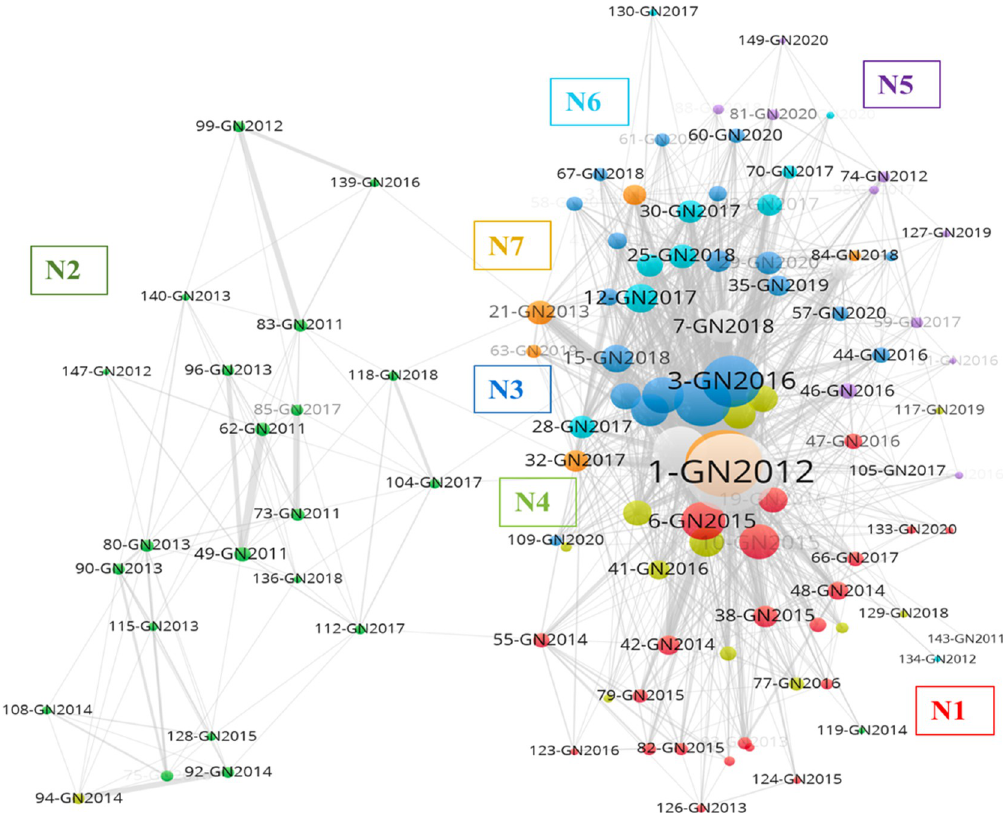
Fig 3. Global North network perspective of information science scholarly network on AI